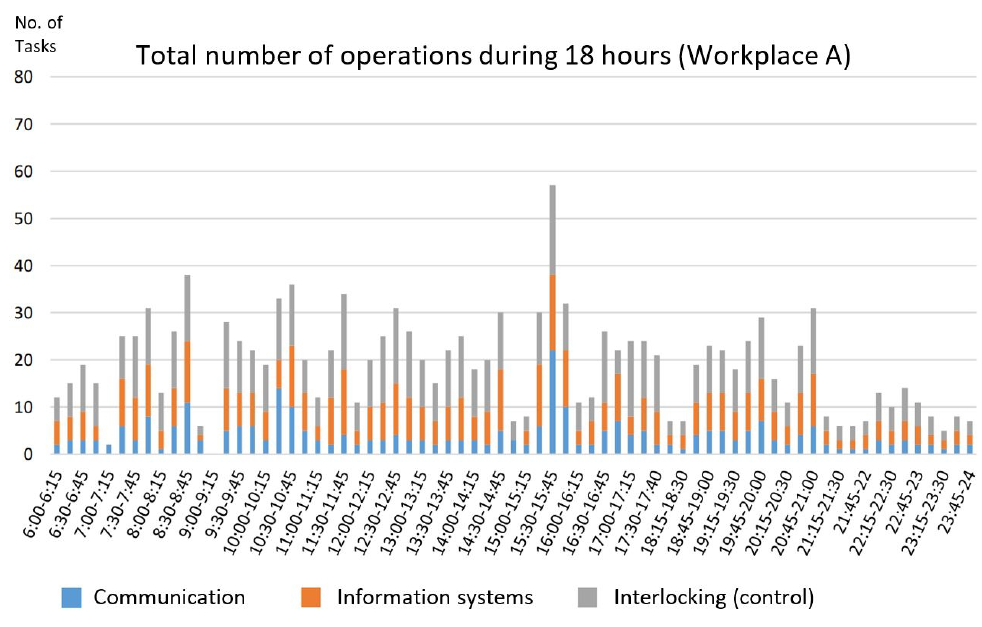
Figure 6. Distribution of operations, tasks and errors over the observed period of 18 h at workplace A.